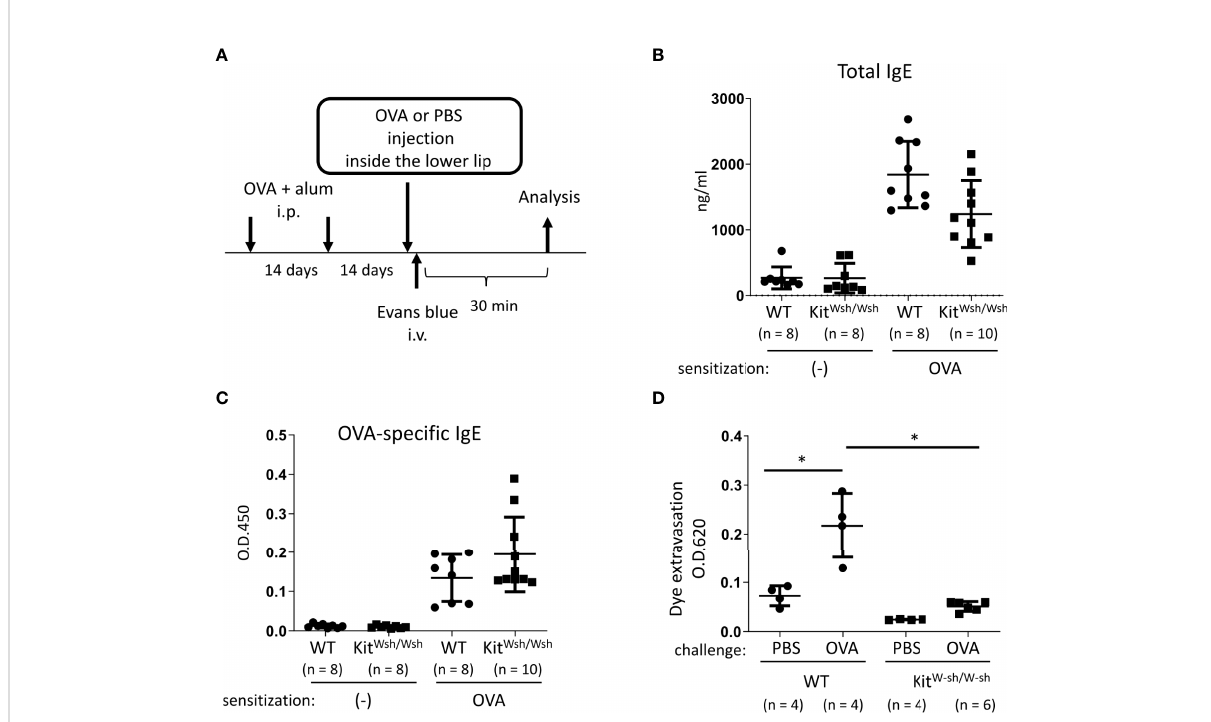
FIGURE 2 Development of murine model of IgE- and mast cell-mediated allergic reaction in oral cavities. (A) A schematic representation of murine models of OVA-induced, IgE- and mast cell-dependent allergic reaction in oral cavities. (B, C) Serum levels of total IgE (B) and OVA-speci fi c IgE (C) from WT mice (n = 8) or Kit W-sh / W-sh mice (n = 10) intraperitoneally injected with OVA plus alum twice at a 2-week interval or from non- sensitized WT mice (n = 8) or Kit W-sh / W-sh mice (n = 8). (D) Quanti fi cation of the Evans blue dye that extravasated into the neck skin from OVA- sensitized WT mice stimulated by OVA (n = 4) or PBS (n = 4) or Kit W-sh / W-sh mice stimulated by OVA (n = 6) or PBS (n = 4). Data are presented as mean ± SD. Data are representative of two independent experiments. Brown-Forsythe and Welch ANOVA with Dunnett T3 multiple comparisons. * P <